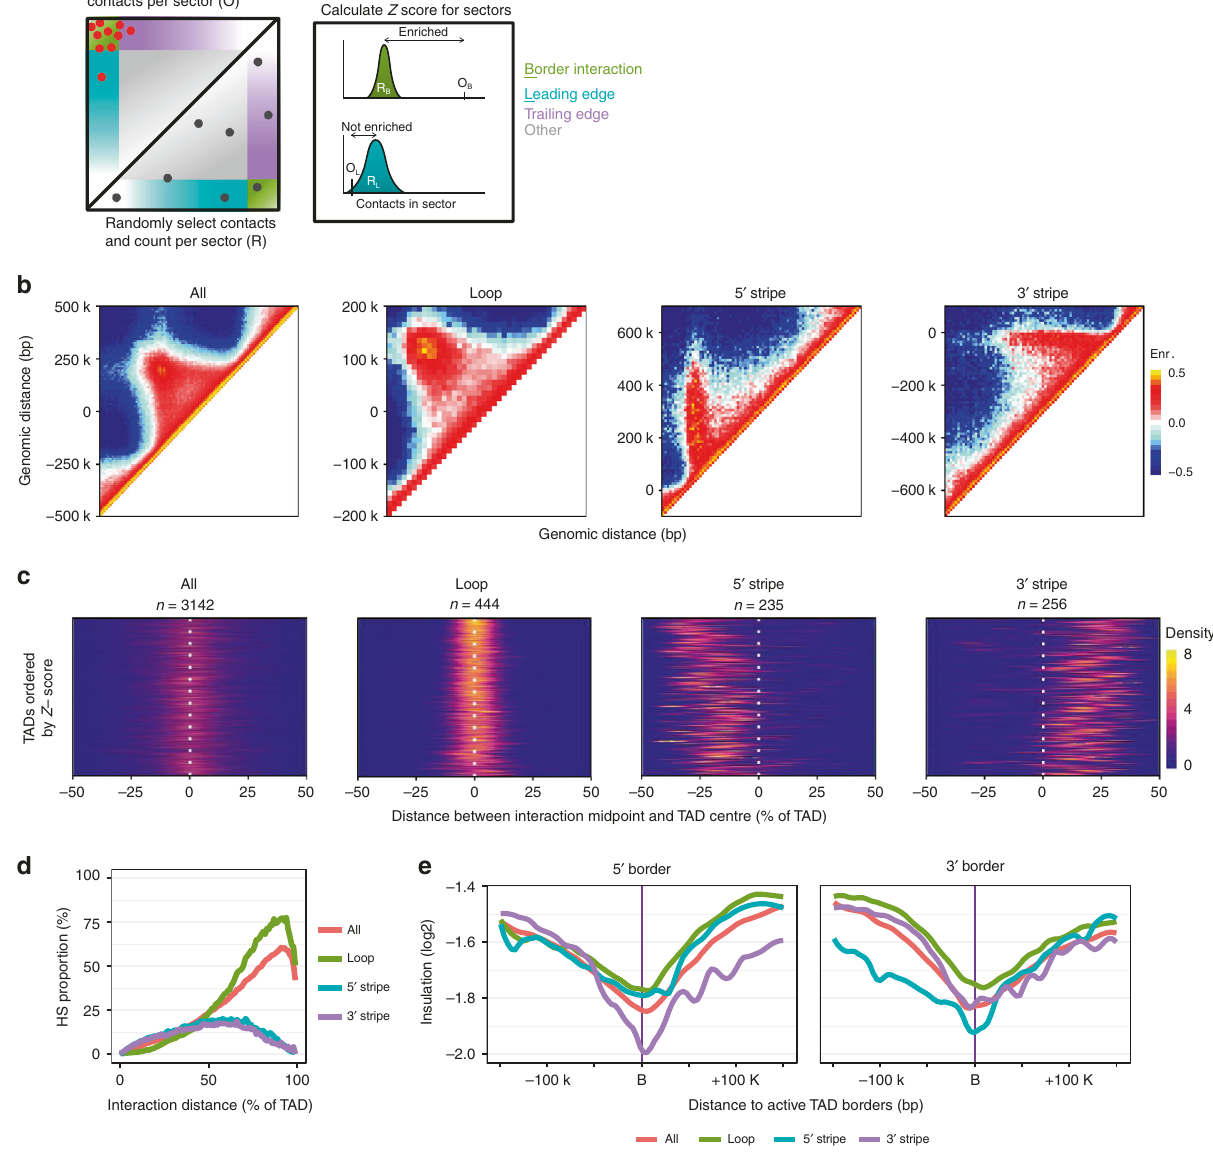
Fig. 2 Unbiased identi fi cation of intra-TAD architecture. a Schematic representation of the analysis approach to classify TADs. See the section “ Methods ” for details. b Aggregate Hi-C contact maps of ESC TAD classes identi fi ed using the approach in a , and size-selected for visualisation ( ‘ All ’ , n = 1259; ‘ Loop ’ , n = 178; ‘ 5 ’ Stripe ’ , n = 93; ‘ 3 ’ Stripe ’ , n = 102). c Distribution of distances between high-scoring contact pairs and the TAD centre, relative to TAD size. All TADs in the class are ordered by Z -score along the y -axis. Yellow represents contact distances with the highest density. d Distribution of distances between high-scoring contact pairs in classi fi ed ESC TADs. TADs were scaled and discretized into 1% bins with the number of high-scoring interactions (score > 40) in each bin is shown as a proportion of interactions of any score in the same bin. e Mean contact insulation (300 kb band) within 150 kb of either the 5 ′ or 3 ′ TAD borders ( ‘ B ’ on the x -axis) and grouped according to TAD